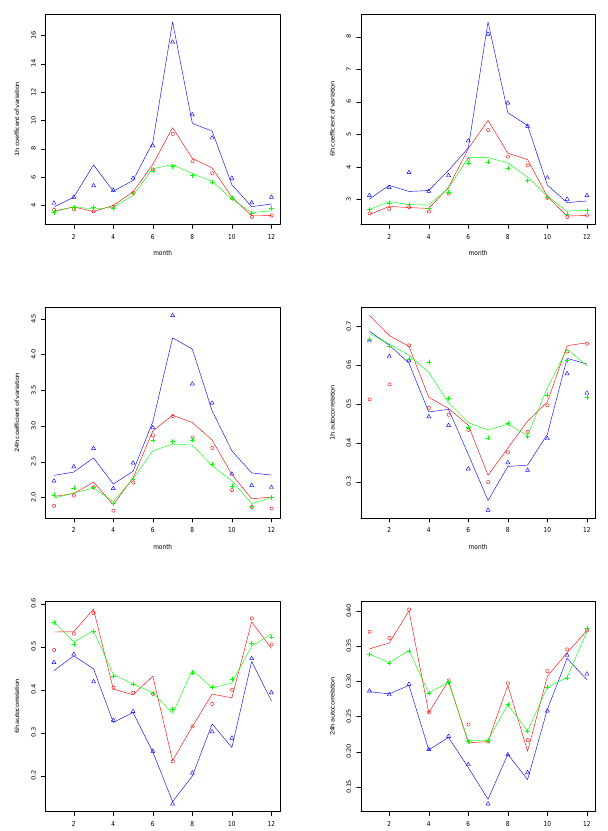
Fig. 4. Fitted (x) and observed (lines) second order properties for the central region (red), southern region (blue) and north-eastern region (green).